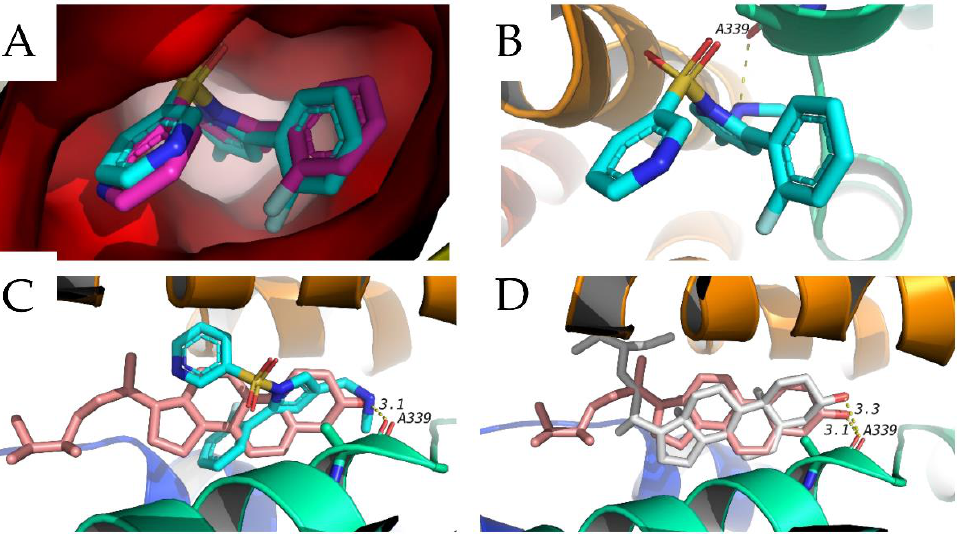
Figure 4. Docking of identified compounds against gastric proton pump (PDB 5YLU). ( A ) Validation of docking procedure with target protein. ( B ) Interactions of vonoperazone (blue) with the active site of protein. ( C ) Docking pose of campesterol (pink) overlapped with co-crystalized ligand (blue). ( D ) Docking pose of stigmasterol (white) and campesterol (pink). Table 2. Docking results of identified compounds against antiulcer